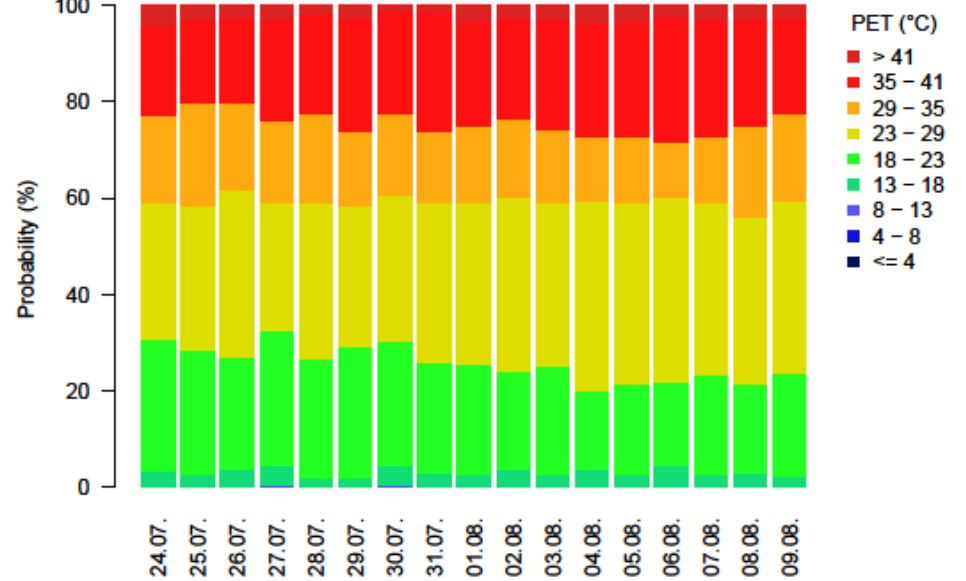
Figure 4. Frequency diagram (decades) showing the average occurrence of modified Physiological Equivalent Temperature (mPET) classes for Tokyo during the period August 1966 to June 2018 (3 h resolution). The reference height for the results is 1.1 m. The sensation classes are defined in Table 2.